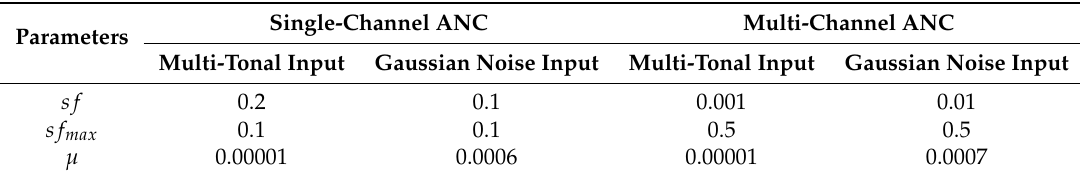
Table 7. Simulation parameters for computer